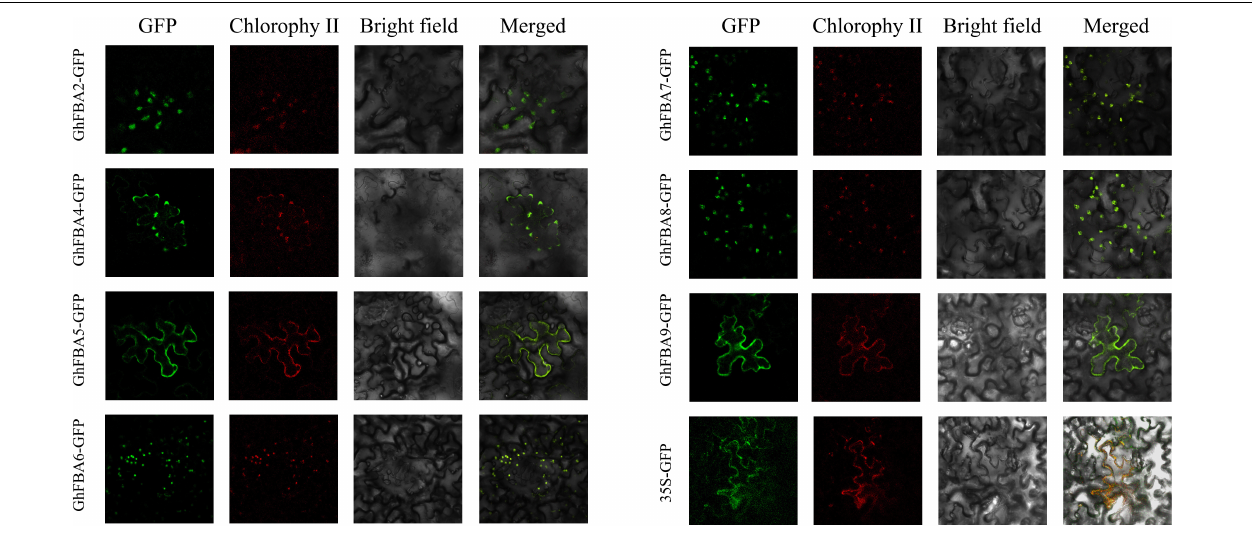
FIGURE 1 | Subcellular location of GhFBAs in tobacco epidermal cells. GhFBAs-eGFP and empty control vector (35S- eGFP ) were transiently expressed in tobacco epidermal cells. And the fluorescent signal was collected by confocal microscope.